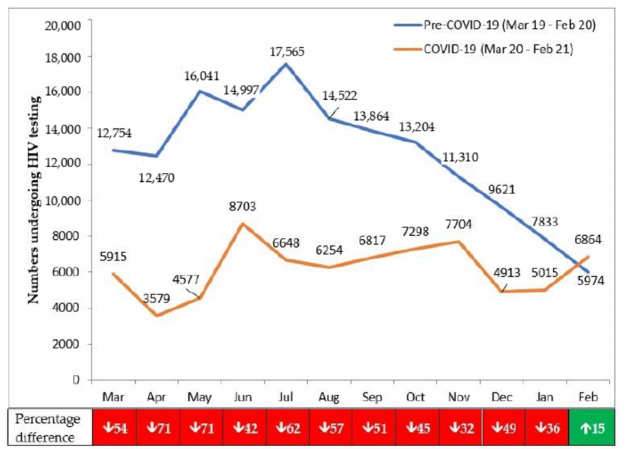
Figure 4. Numbers presenting each month for HIV testing in 18 health facilities in Nairobi, Kenya, during pre-COVID-19 and COVID-19